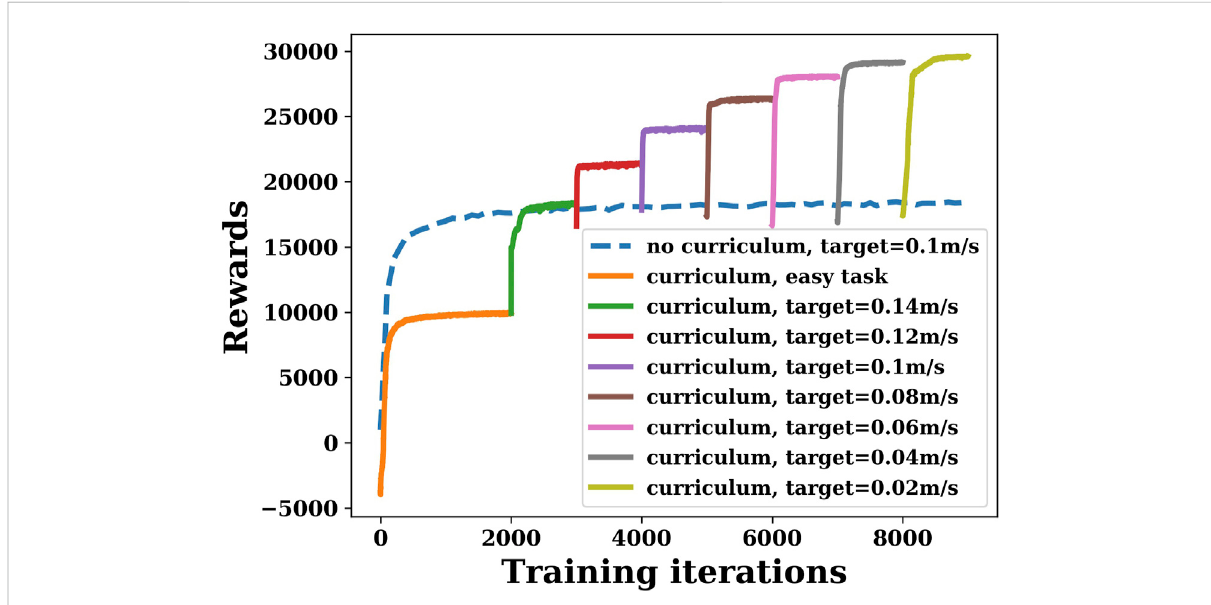
FIGURE 6 Deep reinforcement learning training rewards with or without curriculum learning when joint stiffness is